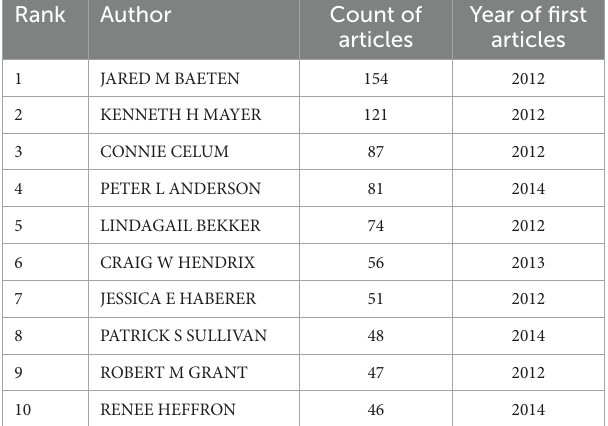
TABLE 1 The top 10 most productive